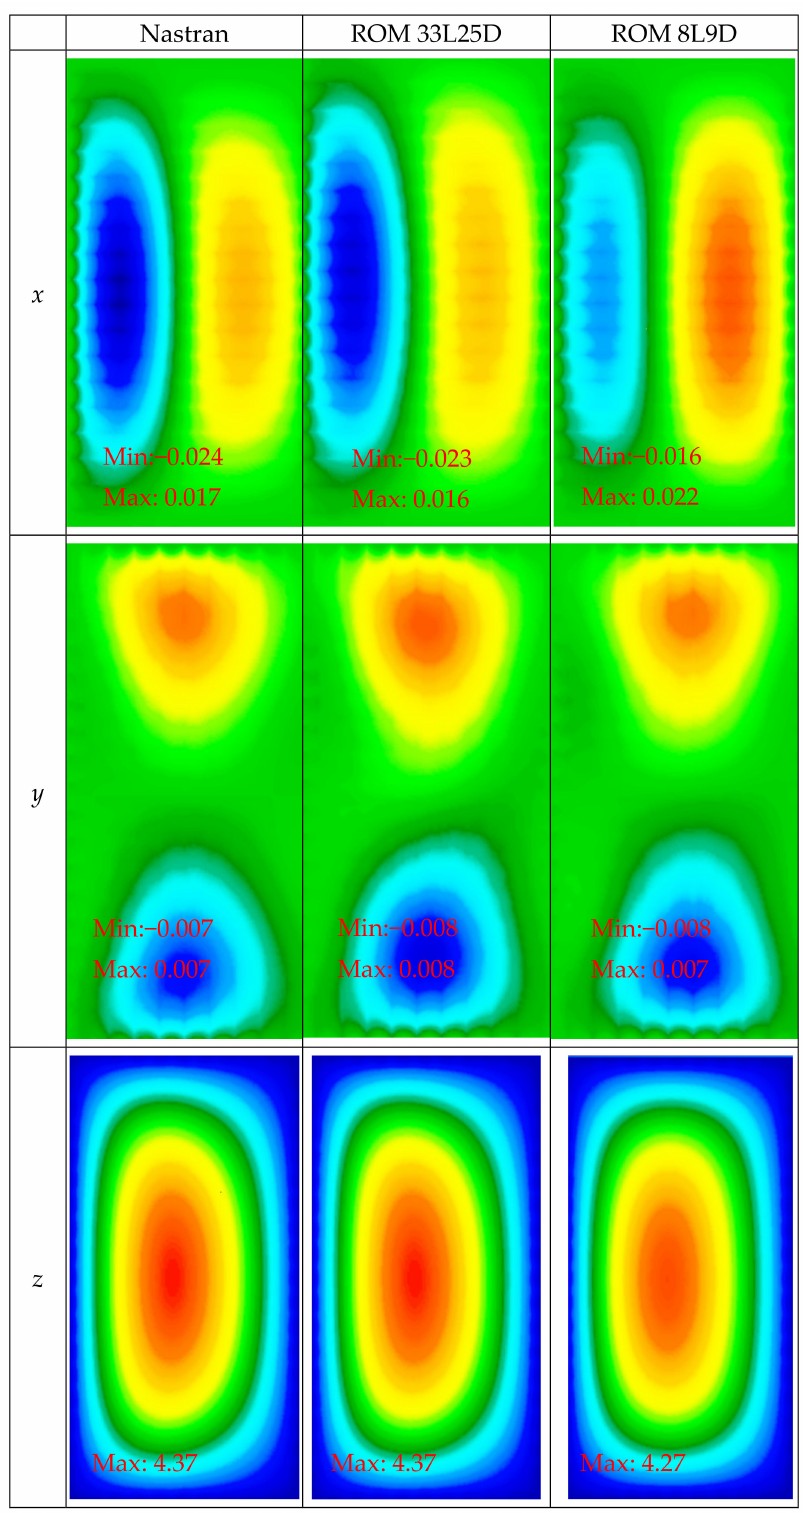
Figure 18. Displacement fields along x , y , z of the skin predicted by Nastran and by the 33L25D and 8L9D ROMs in units of thickness. Left-right asymmetric pressure of magnitude +20